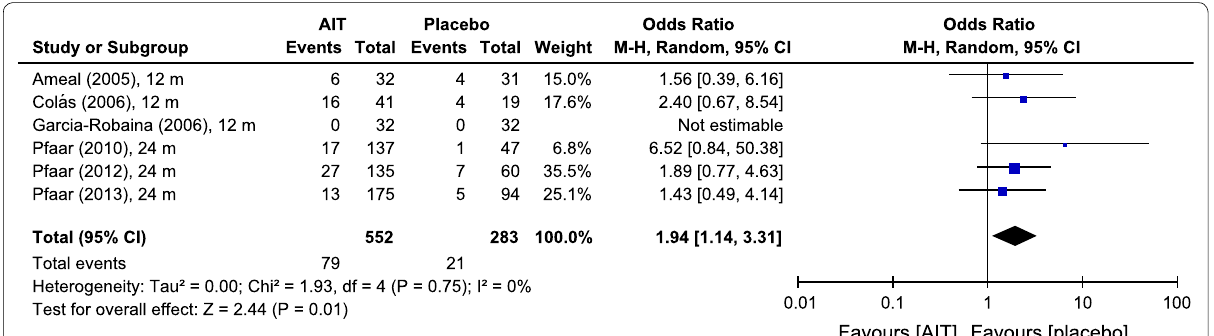
Fig. 9 Risk ratios for systemic reactions under AIT with DPAEs and placebo. Data extracted from the original studies. Outcome: number of systemic reactions after immunotherapy administration. AIT allergen‑specific immunotherapy, CI confidence interval, m